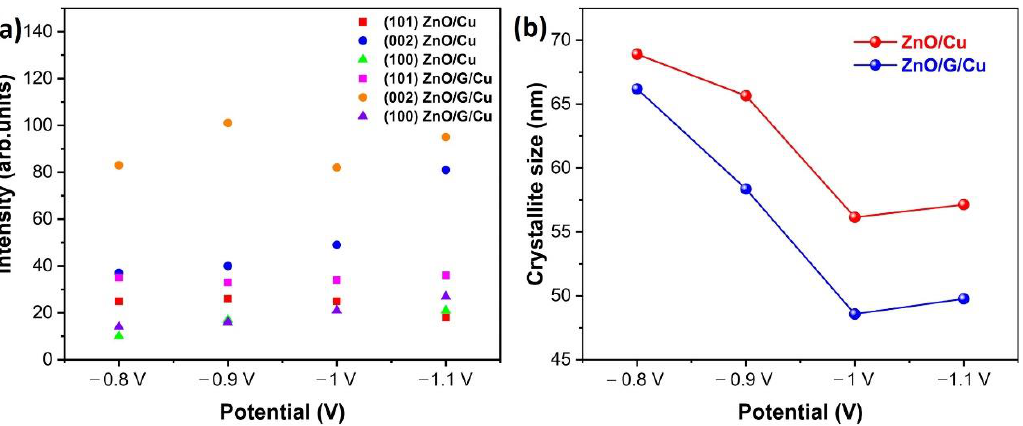
Figure 4. ( a ) The intensity of the (101), (002), and (100) peaks and ( b ) the average crystallite size of ZnO/Cu and ZnO/G/Cu prepared at different applied potentials.